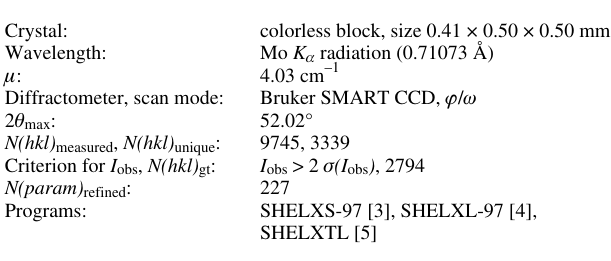
Table 1. Data collection and handling.